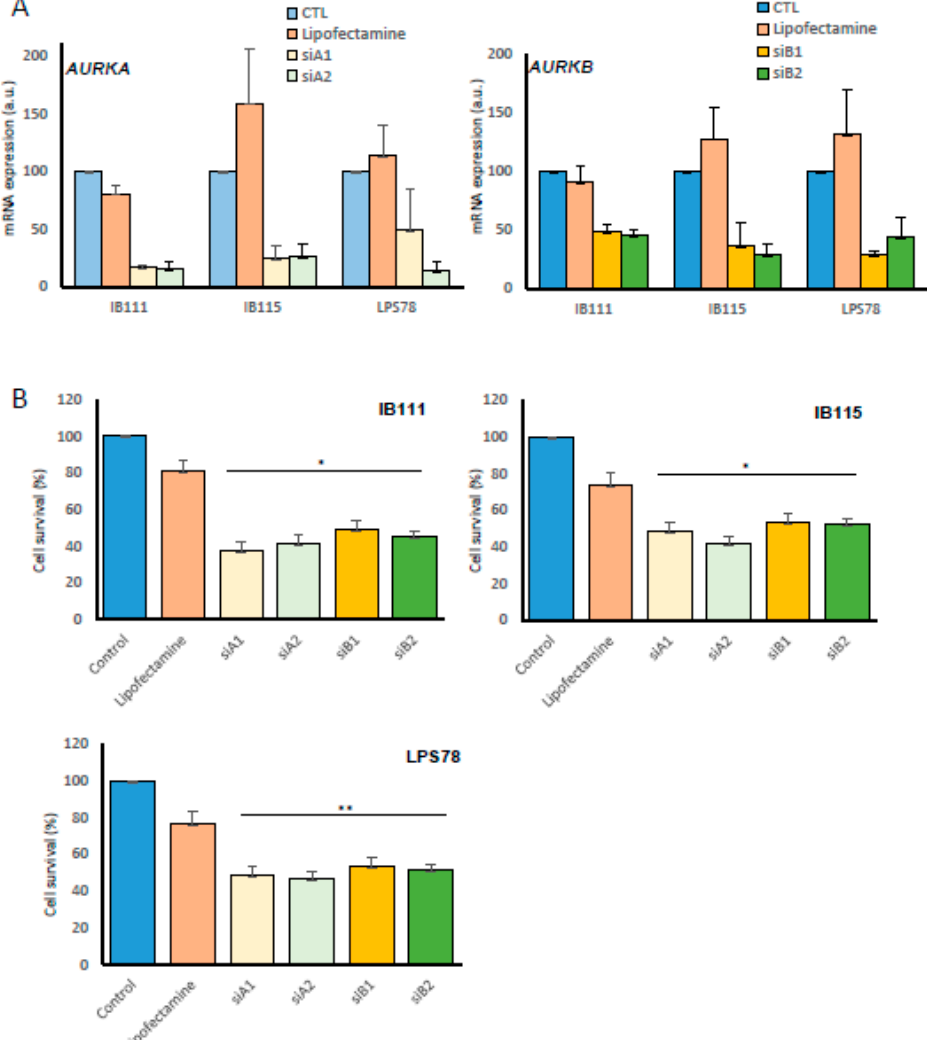
Figure 3. Aurora kinases A and B interfere with LPS cell survival. Three LPS cell lines were challenged with siRNA targeting aurora kinases A and B mRNA. ( A ) Efficiency of RNA silencing. Cells are lipofectamine-transfected with two different siRNAs by gene. After 48h targeted mRNA level of AURKA and AURKB mRNA was determined by q-RT PCR. ( B ) 72h after transfection, cell survival was assayed with MTT assay in the LPS cell lines. Histograms represent mean values of independent experiments done in duplicate or triplicate +/ − SEM. (*: p < 0.05; **: p < 0.01).